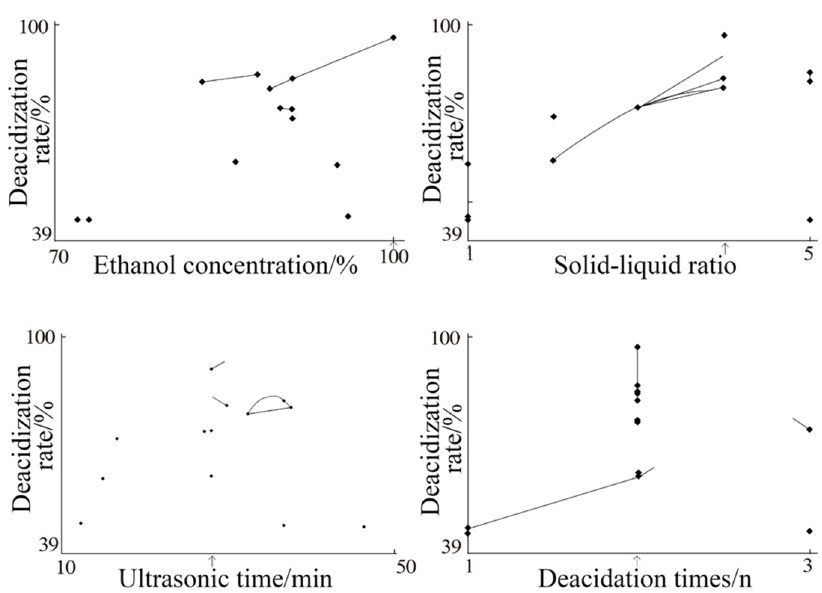
Figure 1. Mapping of the conditions from the first-round optimization.